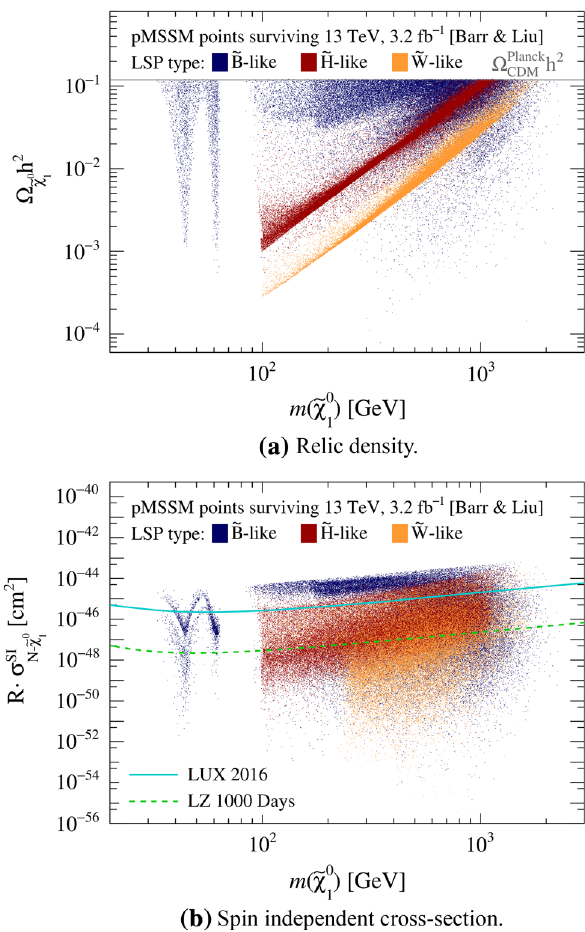
(b) Spin independent cross-section. Fig. 8 Model points surviving the constraints from the six 13 TeV Fig. 7 Most sensitive analysis used to constrain each of the 28.5k ATLAS searches considered in Ref. [55], projected into relic density points excluded at 95% confidence level by the six 13 TeV searches dis- ( a ) and spin-independent LSP-nucleon cross section ( b ) vs. LSP mass played in Table 1. A marker is styled according to the analysis with the ) . The points are coloured by the composition of the neutralino m ( ˜ χ 0 1 lowestCLsvalue,asdescribedinFig.1.Thisisprojectedintotheplanes LSP being dominantly bino ( blue ), Higgsino ( red ) or wino ( orange ) as ) againstrelicdensity( a )andspin-independentLSP– ofLSPmass m ( ˜ χ 0 1 defined in Table nucleon cross section σ SI ( b ). The grey line overlayed on a indicates N −˜ χ 0 1 h 2 measuredbyPlanck[101].In b ,the theobservedrelicdensity Ω Planck CDM h 2 /Ω Planck h 2 of the neu- cross section is scaled by the ratio R = Ω χ 0 CDM 1 h 2 to that observed Ω Planck h 2 . Overlayed on b tralino relic density Ω χ 0 CDM 1 are upper limits at 90% confidence level on the cross section observed by the LUX 2016 [78] ( solid light blue ) results, together with the pro- jected limit from 1000 days of data taking by the LZ experiment [107] ( dashed green ). The central value of the limit from LUX 2016 is twice